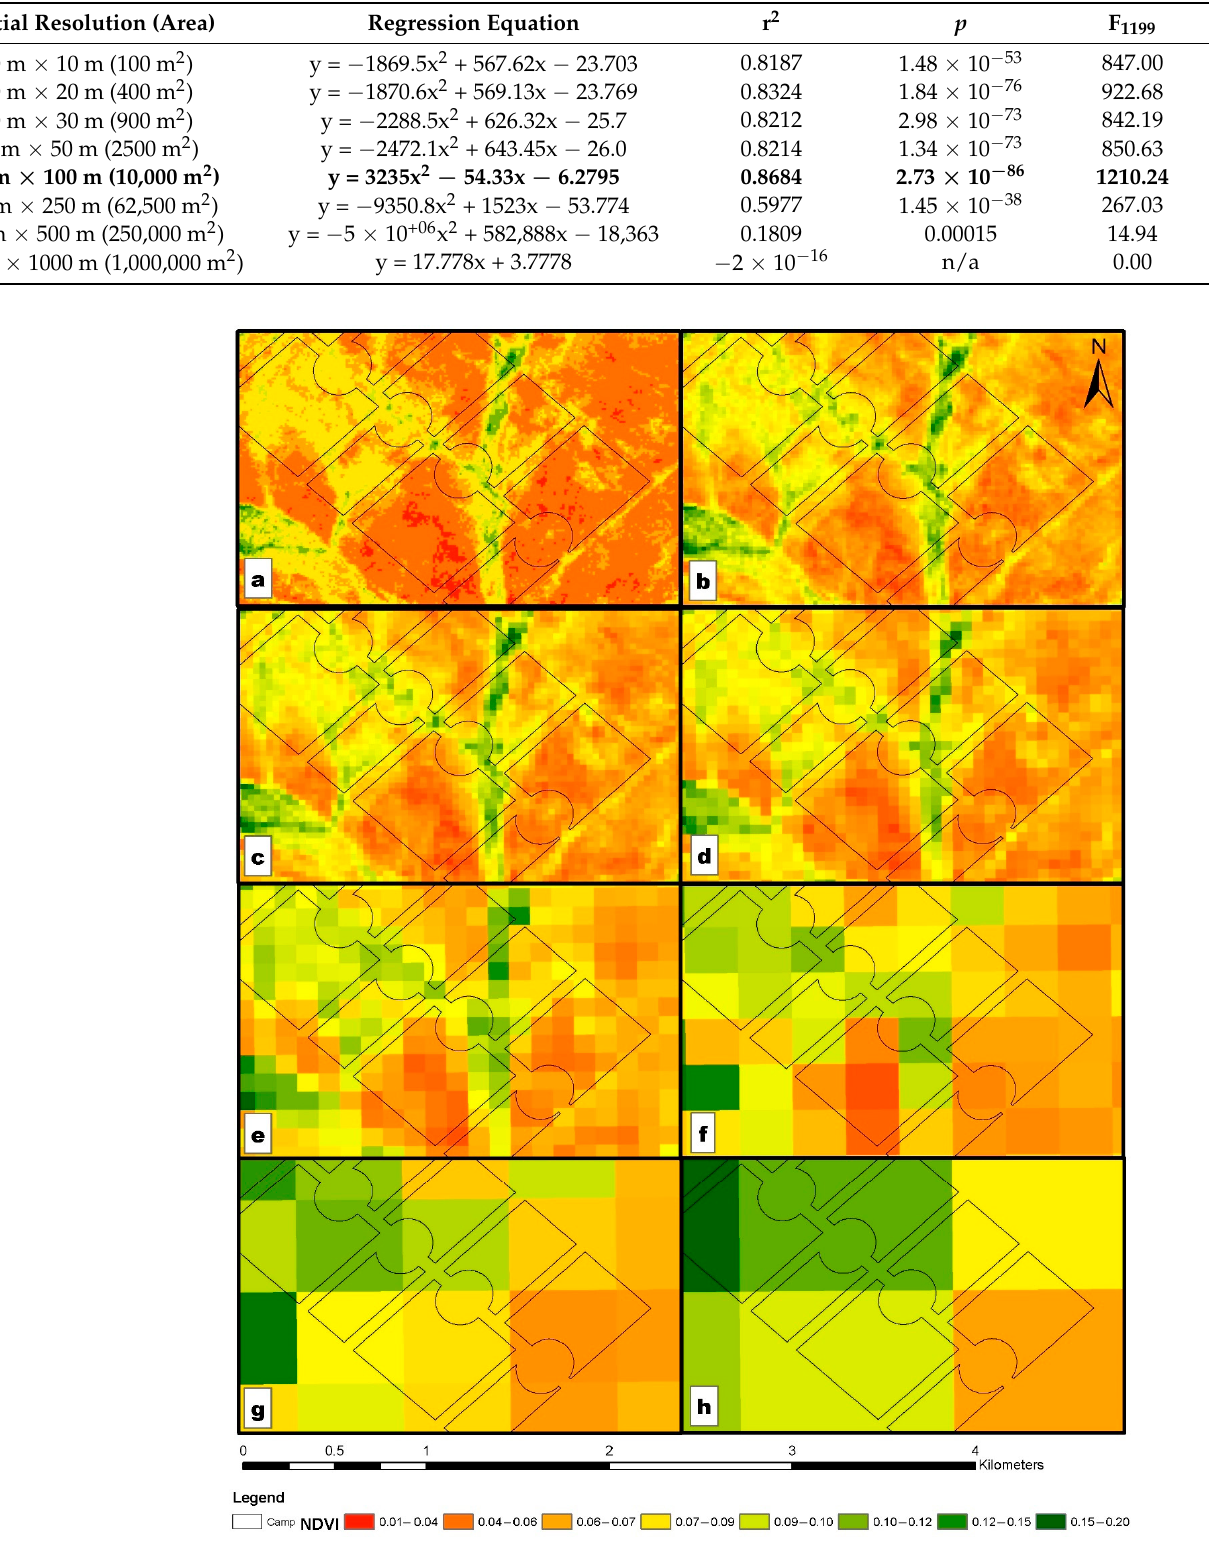
Table 4. Regression and test statistics of linear and quadratic regression analyses fitted to the Gi* z-score from the optimized hotspot analysis and NDVI scores.